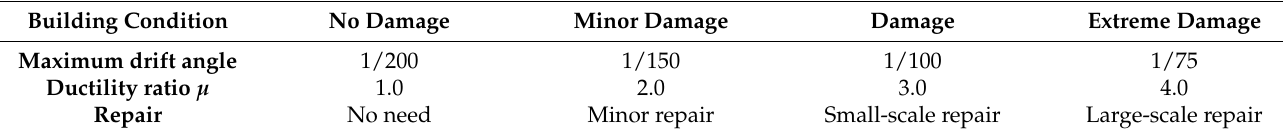
Table 2. Relationship between the steel moment frame system and maximum interstory drift angle [30]. Building